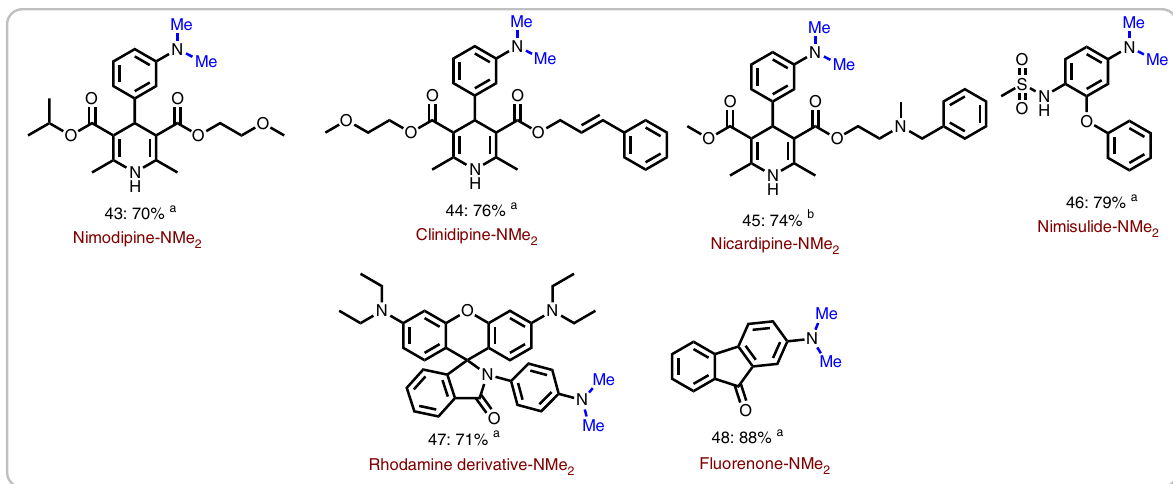
Fig. 4 N -methylation of pharmaceutical and fl uorescent molecules a . Selective conversion of nitro groups to N -methyl moiety in selected drug and fl orescent molecules using iron catalyst. Iron-catalyzed reductive amino-methylation of existing drug molecules a Reaction conditions: 0.5 mmol nitroarene, 50 mg Fe 2 O 3 /NGr@C, (5 mol% Fe), 10 mmol paraformaldehyde (300 mg), 1 mmol Na 2 CO 3 , 2 mL DMSO-water (1:1), 130 °C, 30 h, isolated yields. b same as ‘ a ’ with 20 mmol (600 mg)